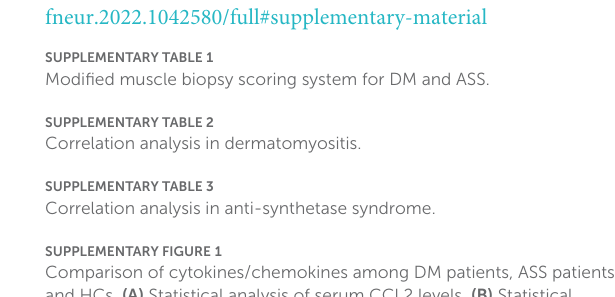
SUPPLEMENTARYTABLE1 Modified muscle biopsy scoring system for DM and ASS. SUPPLEMENTARYTABLE2 Correlation analysis in dermatomyositis. SUPPLEMENTARYTABLE3 Correlation analysis in anti-synthetase